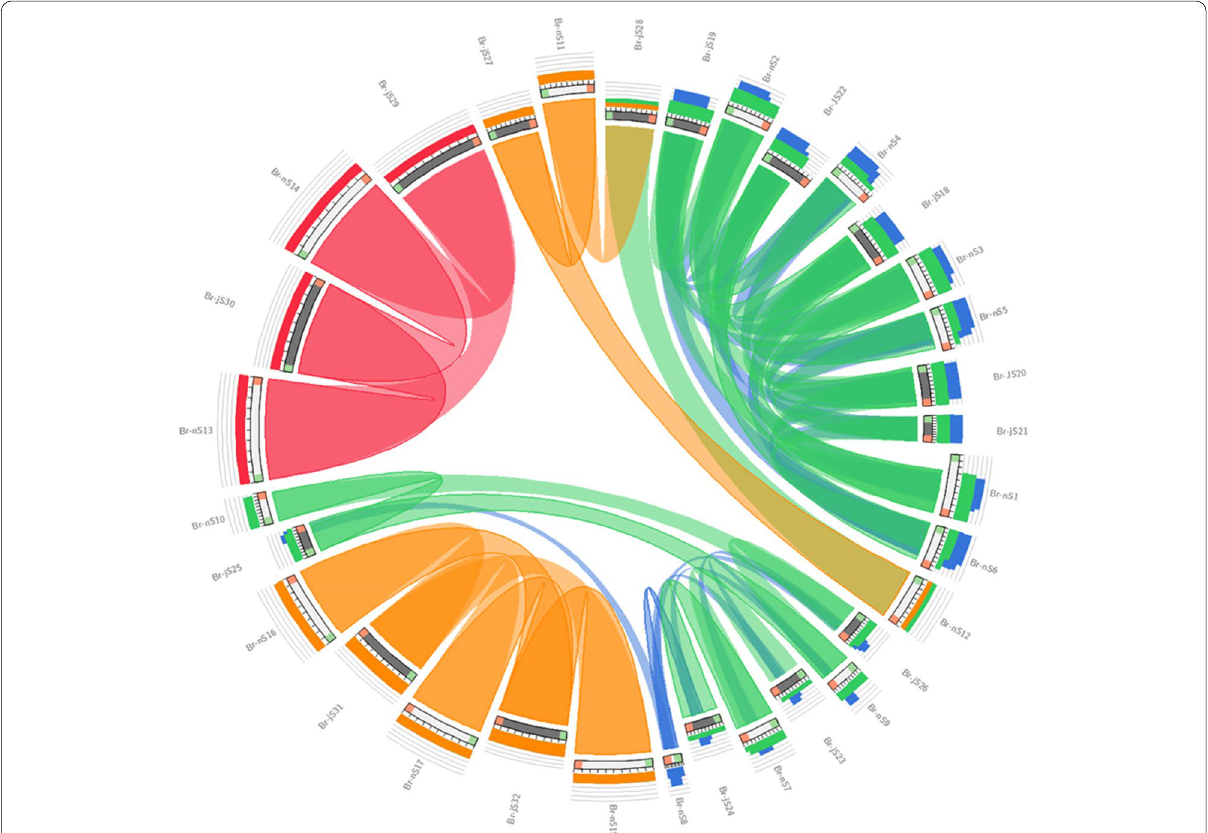
Fig. 5 Representation of synteny of B. napus and B. juncea identifying the level of conservation at the sequence level in 4 colors. The red, green, orange, and blue colors signify the level and intensity of evolutionary conservation among distinct shattering genes, e.g. maximum intensity is from orange to